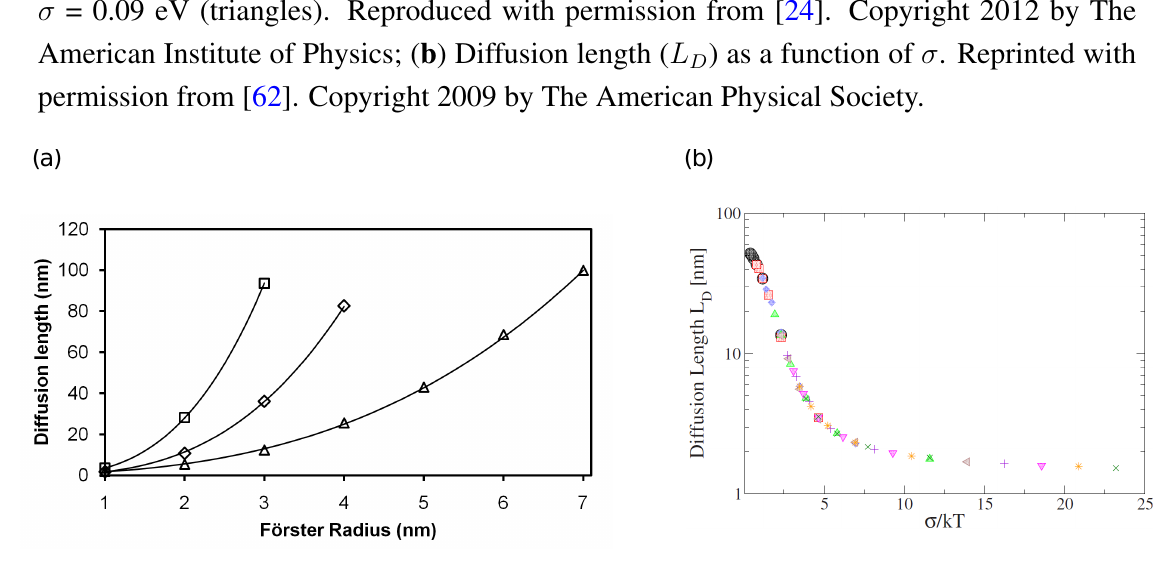
σ = 0.09 eV (triangles). Reproduced with permission from [24]. Copyright 2012 by The American Institute of Physics; ( b ) Diffusion length ( L